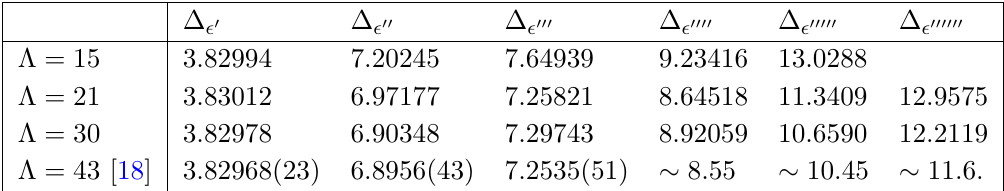
, ∆ , θ ) = ( 0 . 518148953 , 1 . 412627358 , 0 . 9692651416 ). φ φ 2